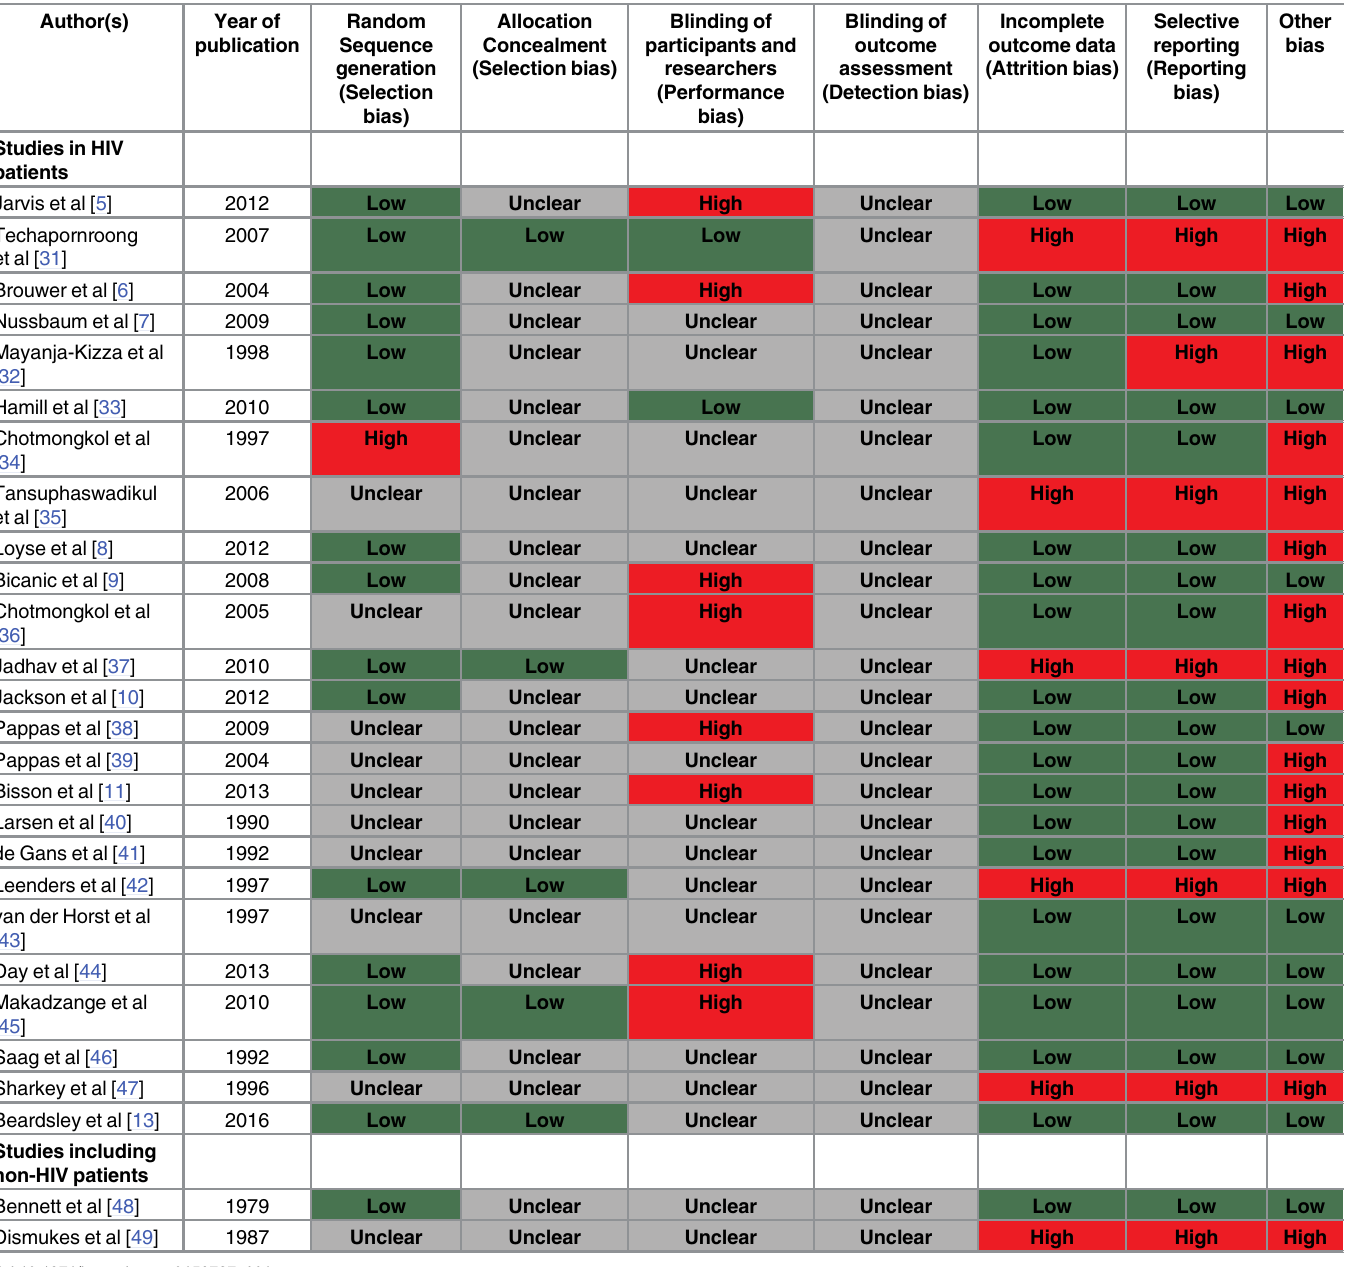
Mean rates of CSF culture negativity were 42.5% (SD ±0.24) and 63.3% (SD ±0.20) at 2 weeks (11 studies, 27 treatment groups) and 10 weeks (5 studies, 10 treatment groups), respec- tively. Mean EFA slope was -0.41 cfu/ml CSF/day (SD ±0.13) among studies that measured this microbiological outcome (9 studies, 24 treatment groups). Among studies that reported CSF culture negativity at 2 weeks, 8 studies reported ACM at 2 weeks, and 5 studies at 10 weeks. Mean EFA slope was reported in 9 studies, of which 8 reported ACM at 2 weeks and 8 reported ACM at 10 weeks.